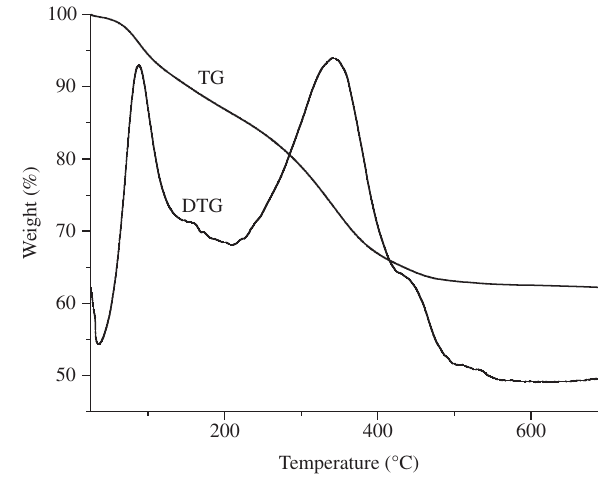
; and b) cyanidin-functionalized TiO 2